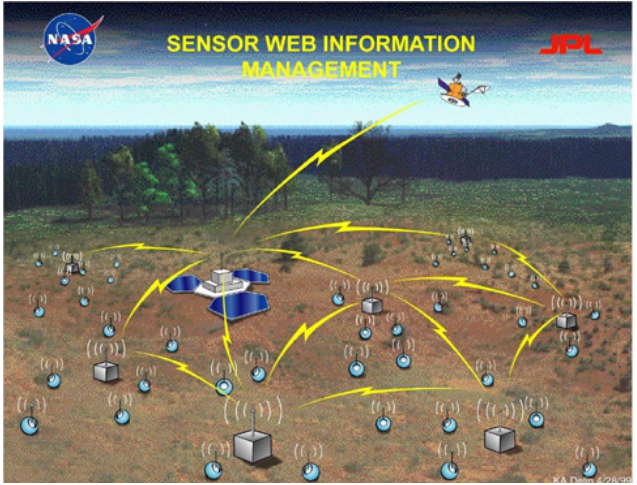
Figure 7. The scale-free nature of the Sensor Web. Notice the first tier of mother pods (cubes) form their own web structure, leading to the idea that the Sensor Web is a web of web nodes. Individual (spherical) pods are not necessarily associated with a particular mother pod, although most tend to be.